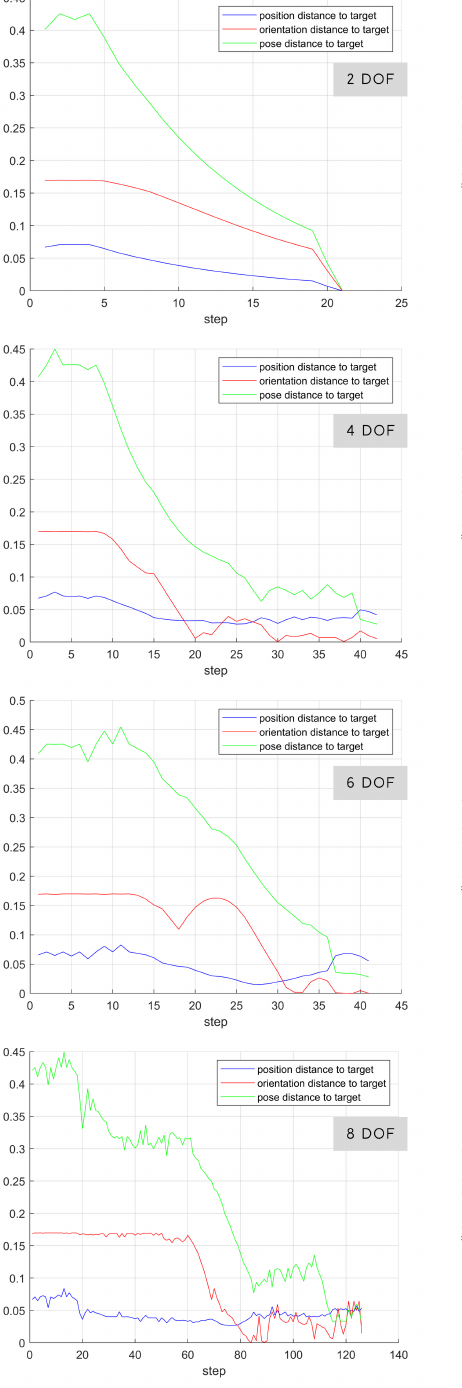
Figure 3. The controller performed the task of reaching, bringing a single control point at the end effector to a desired target pose. As more joints were enabled, the performance was degraded. In particular, in the 2-degrees-of-freedom case, the robot reaches the target in 21 steps, while, in the 9-degrees-of-freedom case, the robot reaches the target in 150